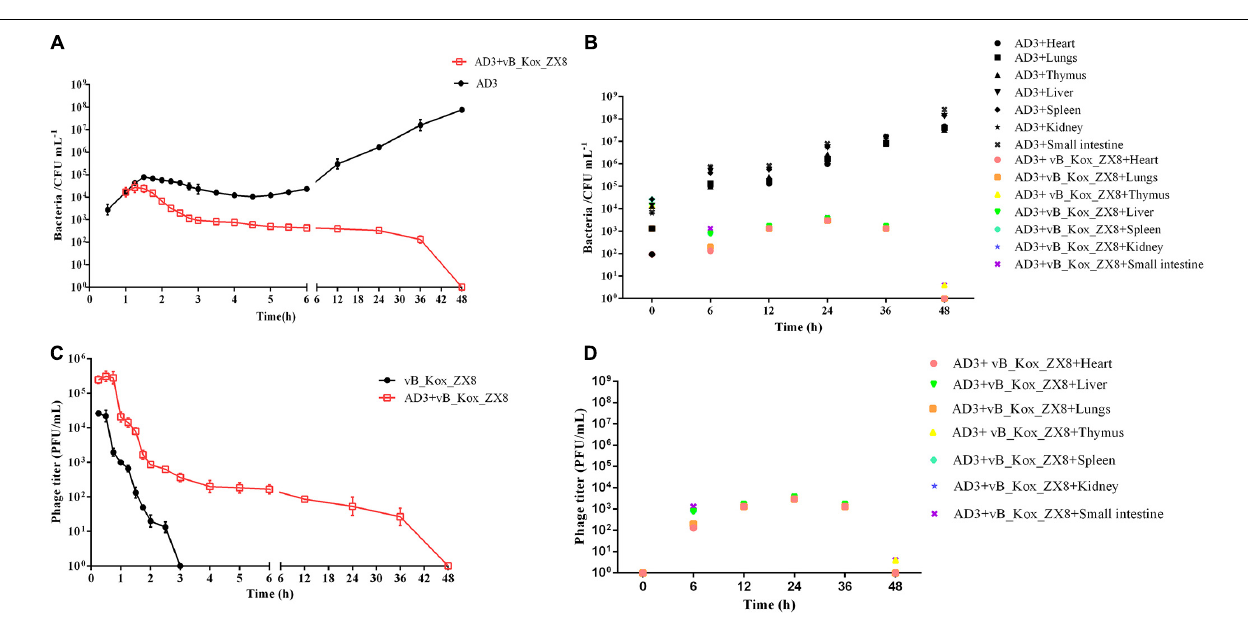
FIGURE 7 | Changes in bacterial and phage titers in bacteremia mice after phage vB_Kox_ZX8 rescue. Bacteria titer in the (A) blood and (B) different organs of bacteremia mice rescued by phage vB_Kox_ZX8; phage titer in the (C) blood and (D) different organs of bacteremia mice rescued by phage